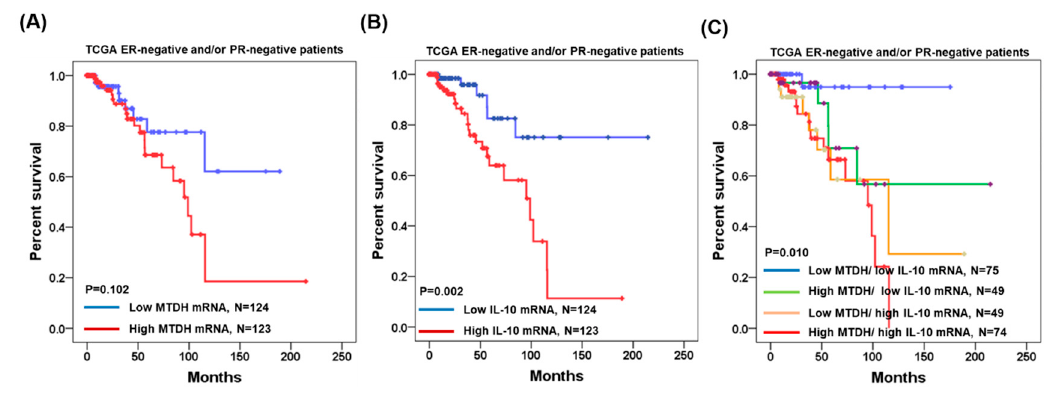
Figure 4. Kaplan–Meier analysis of MTDH and IL ‐ 10 mRNA expressions in 247 ER ‐ negative and/or PR ‐ negative breast cancer patients using TCGA. ( A ) Overall survival estimates for MTDH expression. ( B ) Overall survival estimates for IL ‐ 10 expression. ( C ) Overall survival estimates for MTDH/IL ‐ 10 expression.